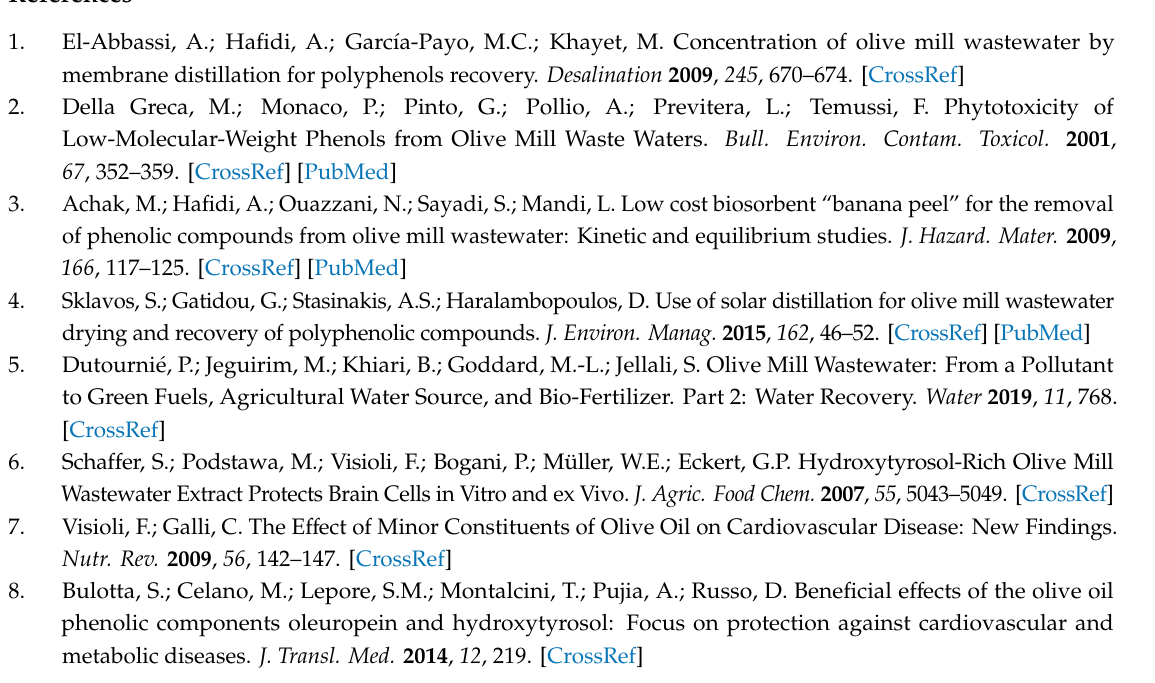
Figure S1: Normalized removal e ffi ciency % data to 0–1 range on the maximal value after 4 h of the uptake process and removal e ffi ciency % at equilibrium for an aqueous solution of phenol and 4-nitrophenol. Figure S2: Fitting of experimental data with linearized Freundlich isotherm model for phenols in OMW (R 2 =